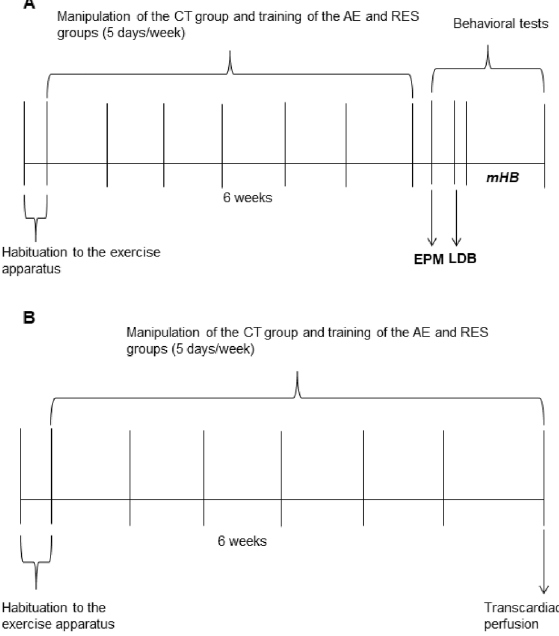
Figure 1. Timeline of the experimental procedures. At the end of the last exercise session, one cohort of animals was used for the behavioral tests ( A ) and the other for the immuno fl uorescence technique ( B ). CT: sedentary control; AE: aerobic exercise on the treadmill; RES: resistance exercise on the ladder apparatus; EPM: elevated-plus maze; LDB: light-dark box test; mHB: modi fi ed hole board